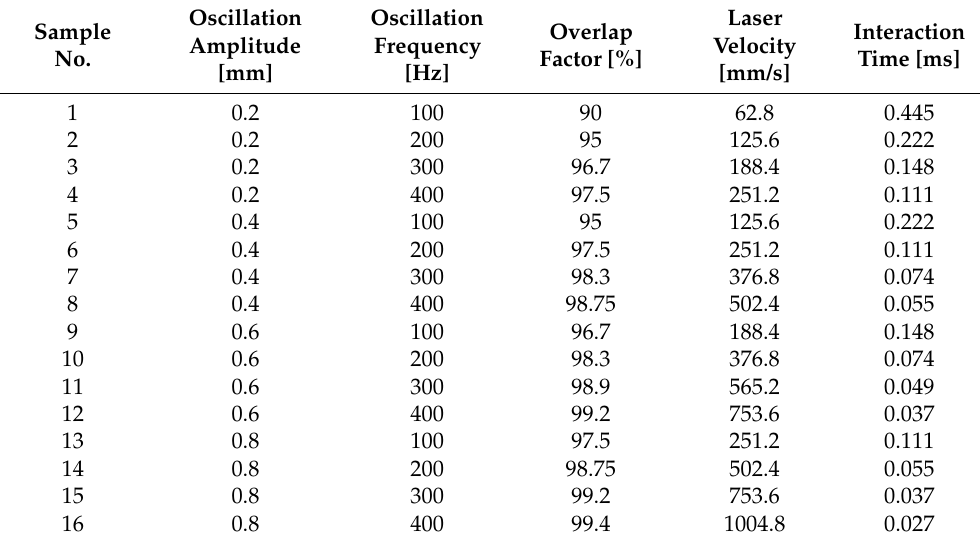
Table 3. The overlap factor, laser velocity, and interaction time for different oscillation amplitudes and